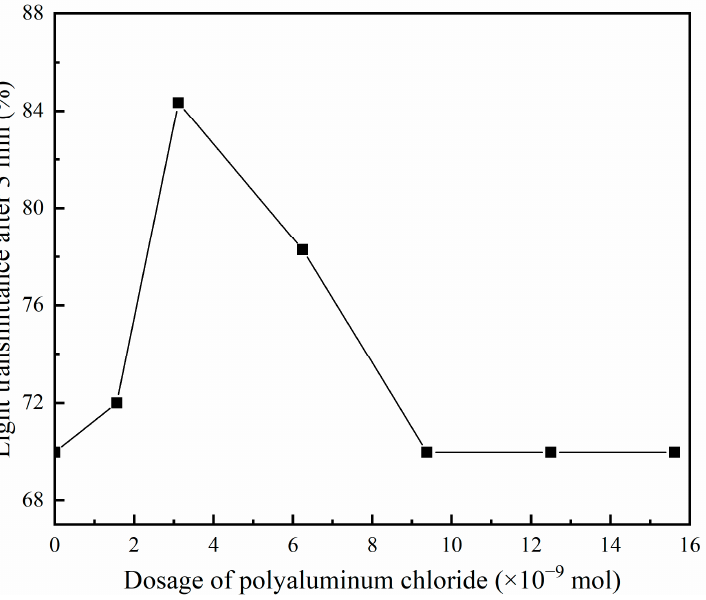
Figure 2. Sedimentation effect of combined use of PAM and polyaluminum chloride (0.66 × 10 − 10